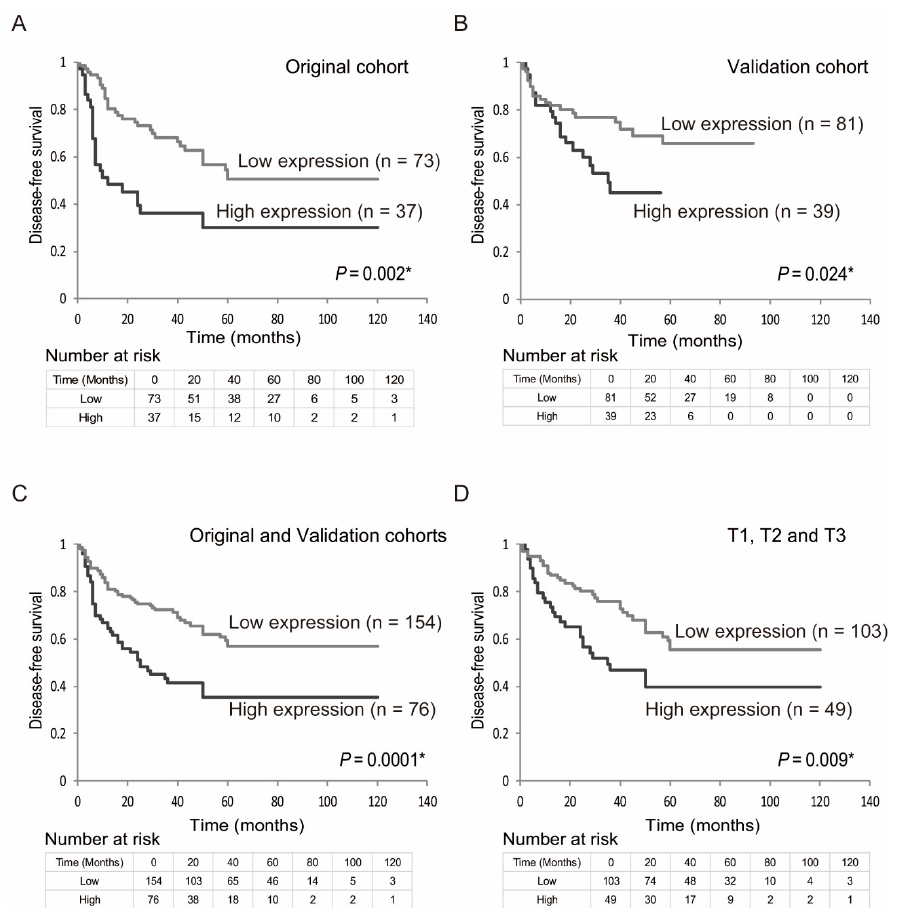
Figure 2. Kaplan-Meier survival curves for patients with head and neck squamous cell carcinoma (HNSCC), based on EZH2 gene expression status. Kaplan–Meier survival curves based on EZH2 gene expression status in patients with HNSCC. Disease-free survival based on ( A ) the original cohort, ( B ) the validation cohort, ( C ) the original and the validation cohort, ( D ) and the original and the validation cohort in tumor stage 1, 2, and 3 patients. Patients were dichotomized into low and high mRNA expression level groups by the optimal cut-off expression value. Gray and black lines indicate patients with tumors displaying EZH2 downregulation and upregulation, respectively. * p < 0.05. Table 2. Multivariate analysis of factors affecting survival using Cox proportional hazards model in 230 HNSCC patients.